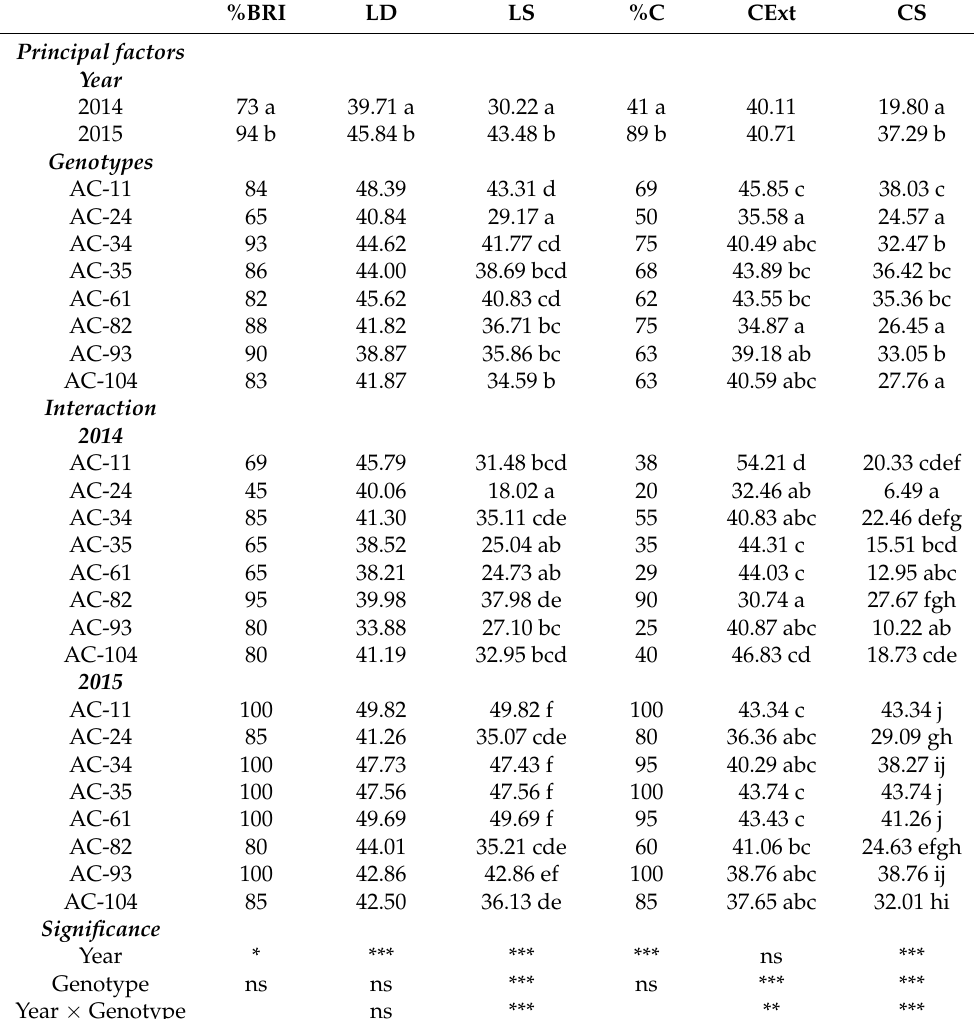
Table 4. Effect of the year and genotype on the disease parameters in the eight selected genotypes from the ‘Andross’ × ‘Calante’ population evaluated during the two years of study